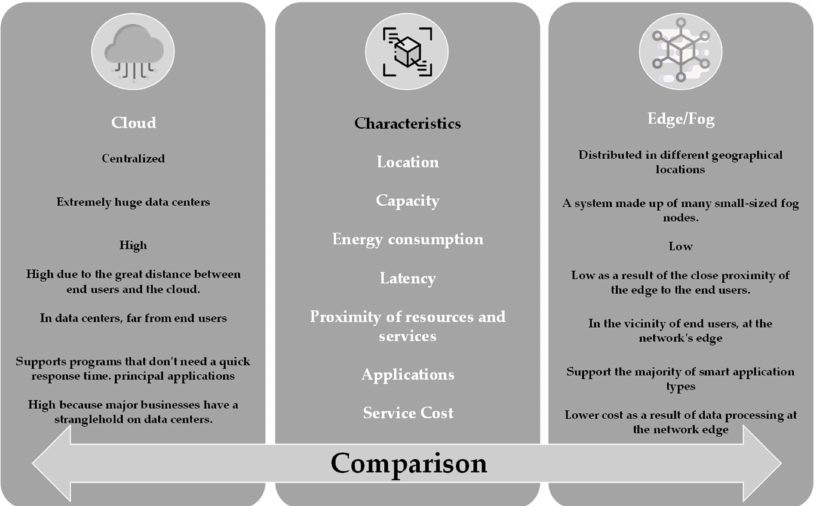
Figure 2. Illustrates the primary differences between cloud computing and edge–fog